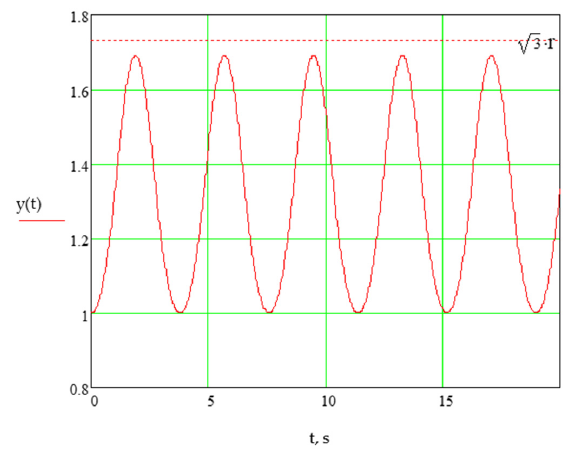
Figure 4. Solution of differential Equation (9).